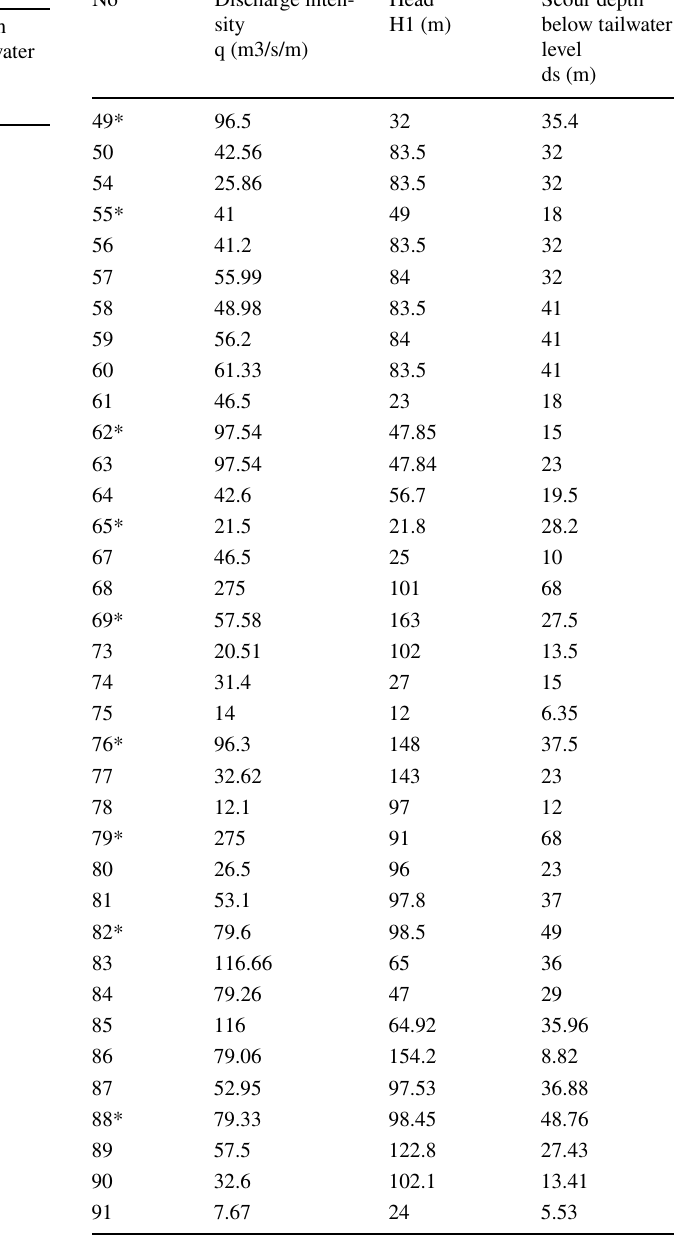
Table 1 Observed data of discharge intensity (q), head (H1), and scour depth